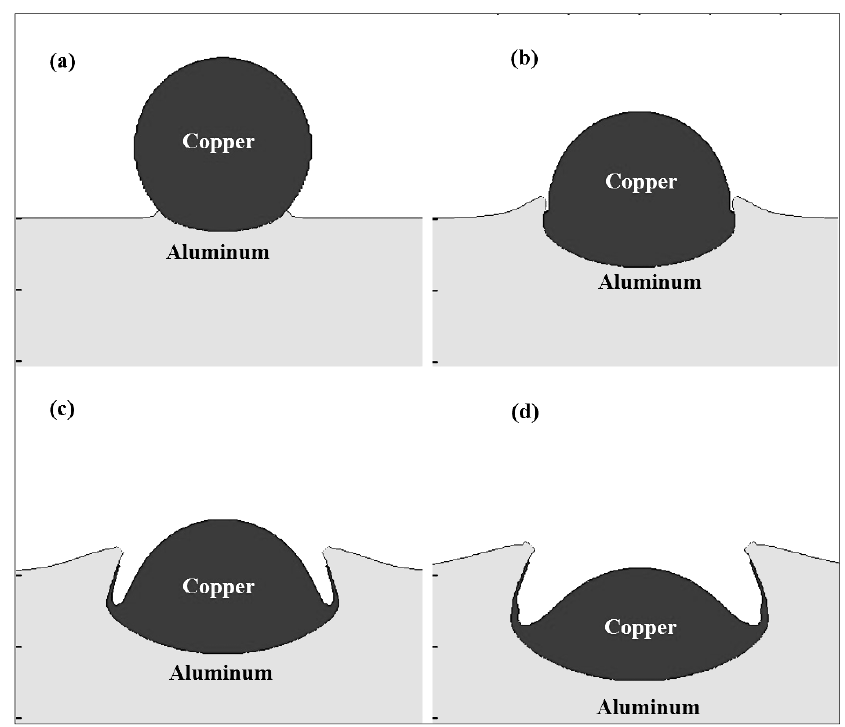
Figure 4. Impact of a Cu particle on Cu substrate at successive times: ( a ) 5 ns; ( b ) 20 ns; ( c ) 35 ns; ( d ) 50 ns [32]. Copyright 2003 Elsevier.